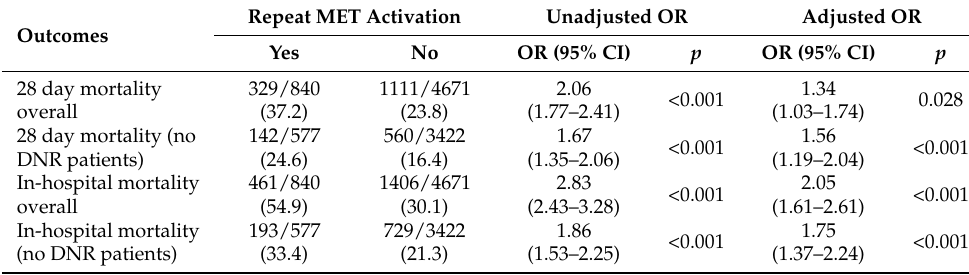
Table 3. Clinical outcomes in patients according to repeat medical emergency team